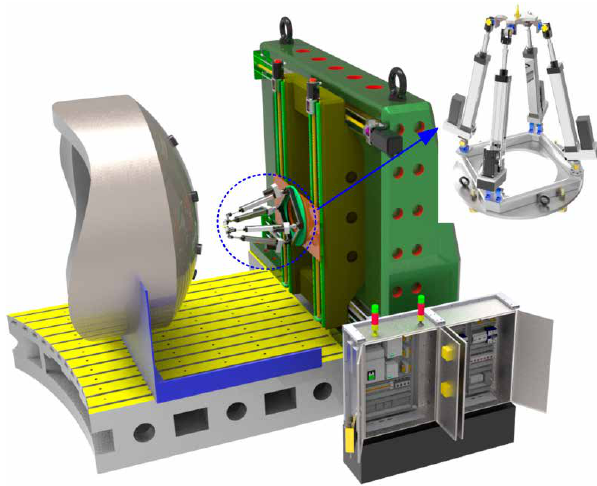
Figure 1: A serial-parallel hybrid kinematic machine.